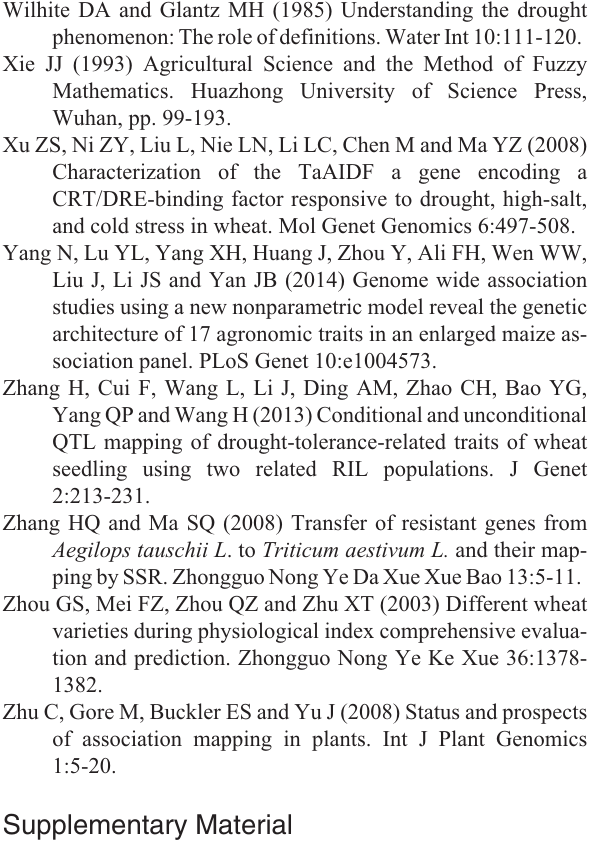
- Table S1 - Genetic correlation among selected traits - Table S2 - Top 10 and bottommost 10 genotypes on DI and D value - Table S3 - Significant SNPs and candidate genes - Figure S1 - The p values of the SNPs and quantile-quantile (Q-Q)